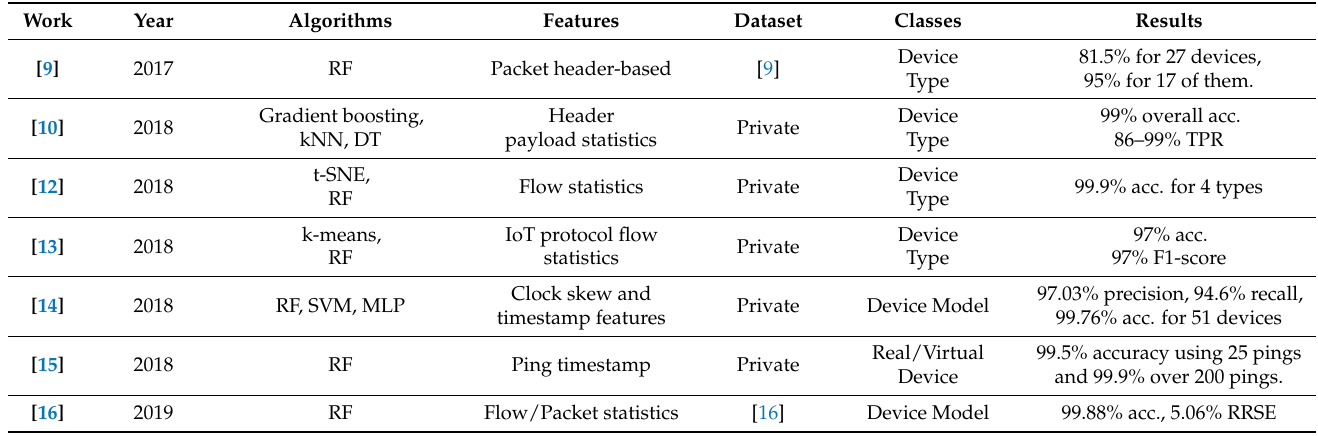
Table 1. Device identification solutions based on device